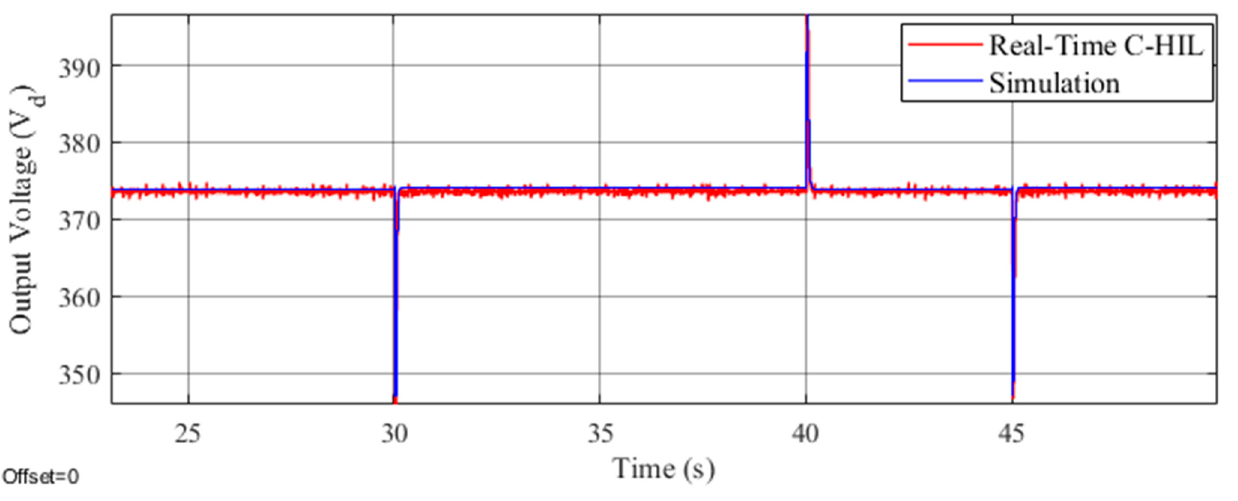
Figure 25. System output voltage.